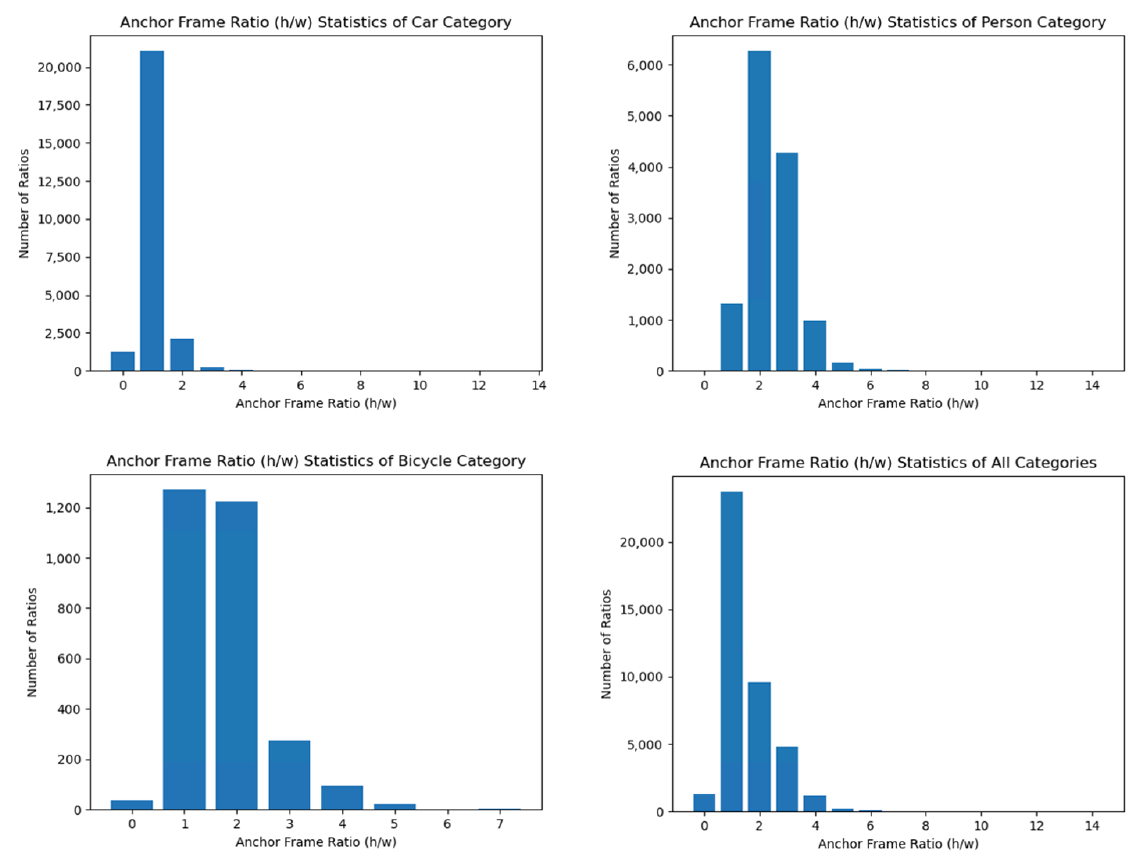
Figure 8. The anchor frame ratio statistics. The horizontal coordinate represents the inverse of the aspect ratio and the vertical coordinate represents the number of different ratios.